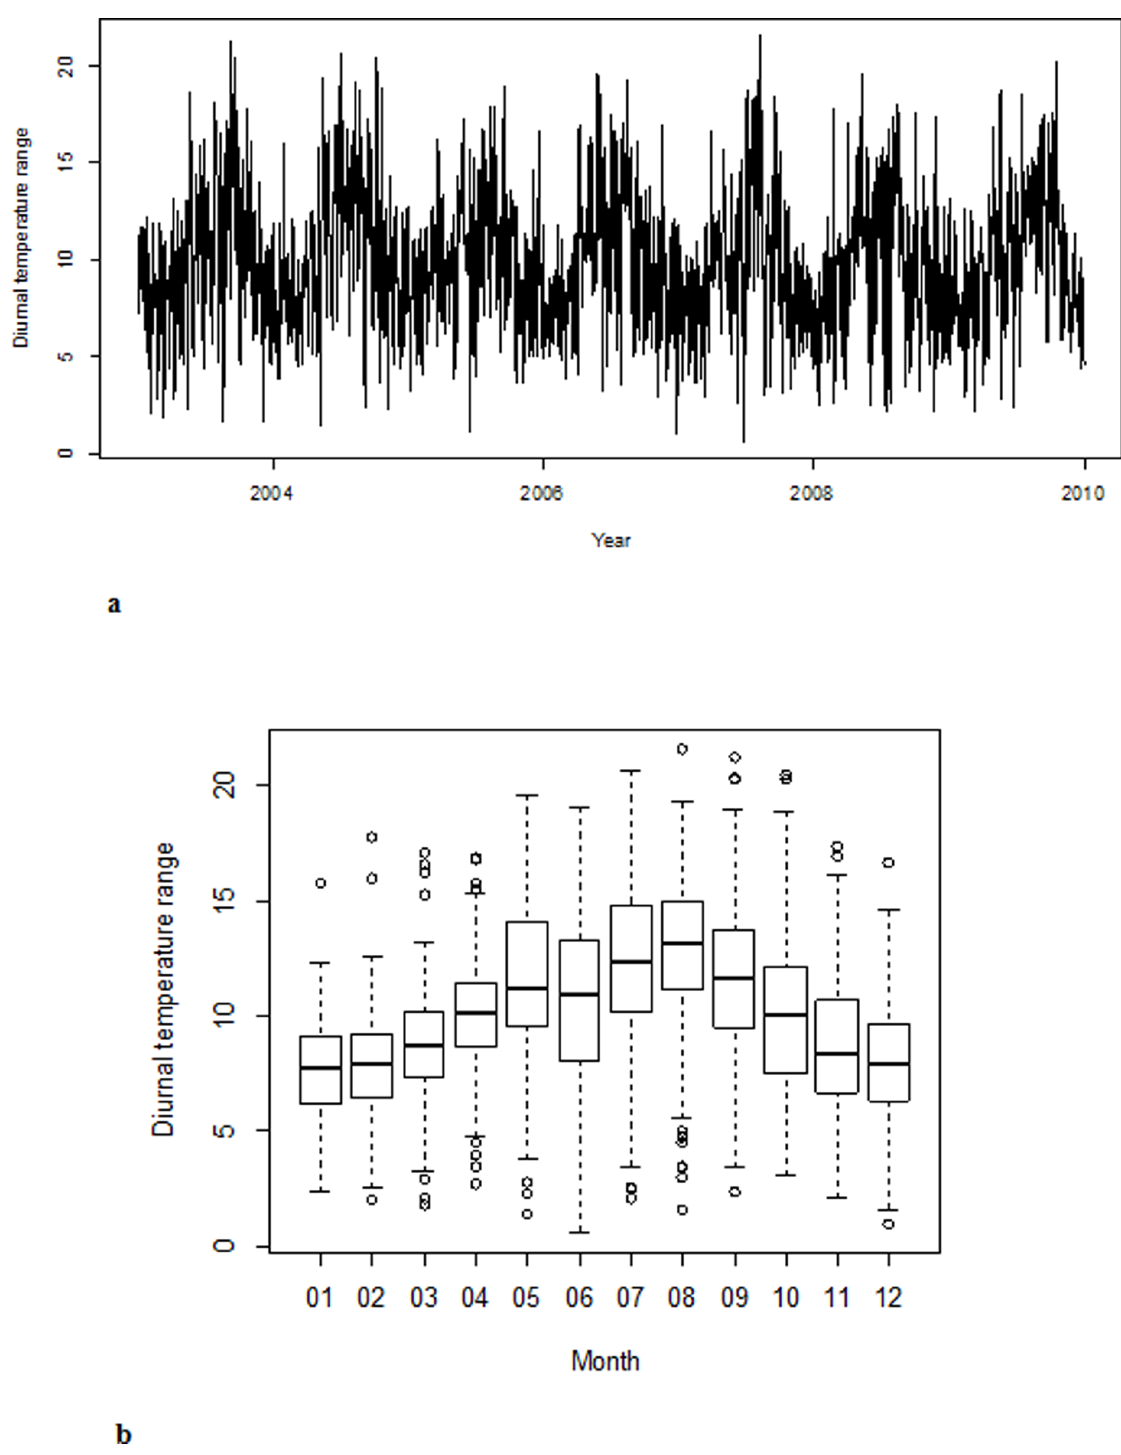
Figure 1. The daily and monthly distribution of diurnal temperature range.